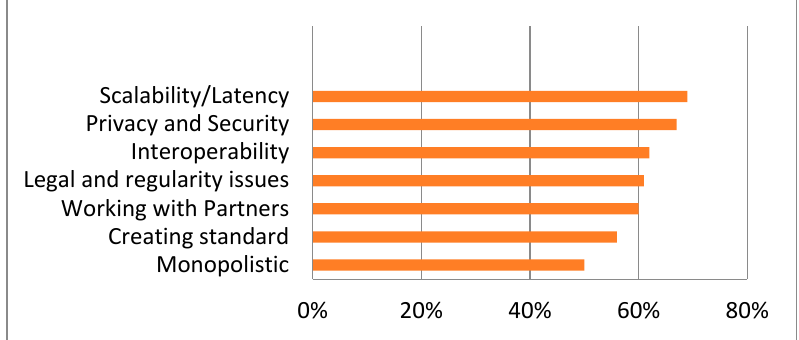
Figure 3. Blockchain awareness among e-healthcare persons [4,5].